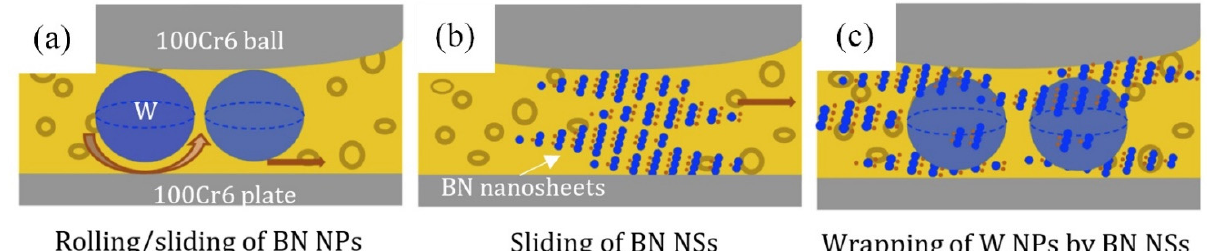
Figure 6. Schematics of friction mechanisms when adding ( a ) W NPs, ( b ) BN NSs, and ( c ) W NPs and BN NSs to PAO6 oil. Adapted with permission from Ref. [294]. Copyright 2020, Elsevier.